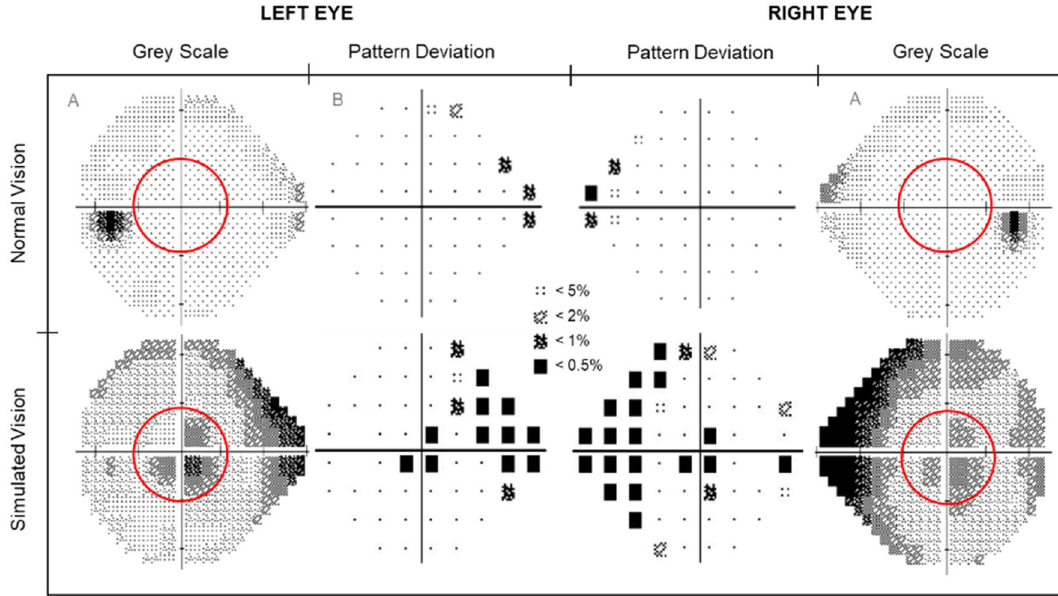
Figure 1. Results of the visual field test. Top row: normal visual field in the left and right eye. Bottom row: simulated macular degeneration visual field with a central 10° scotoma (red